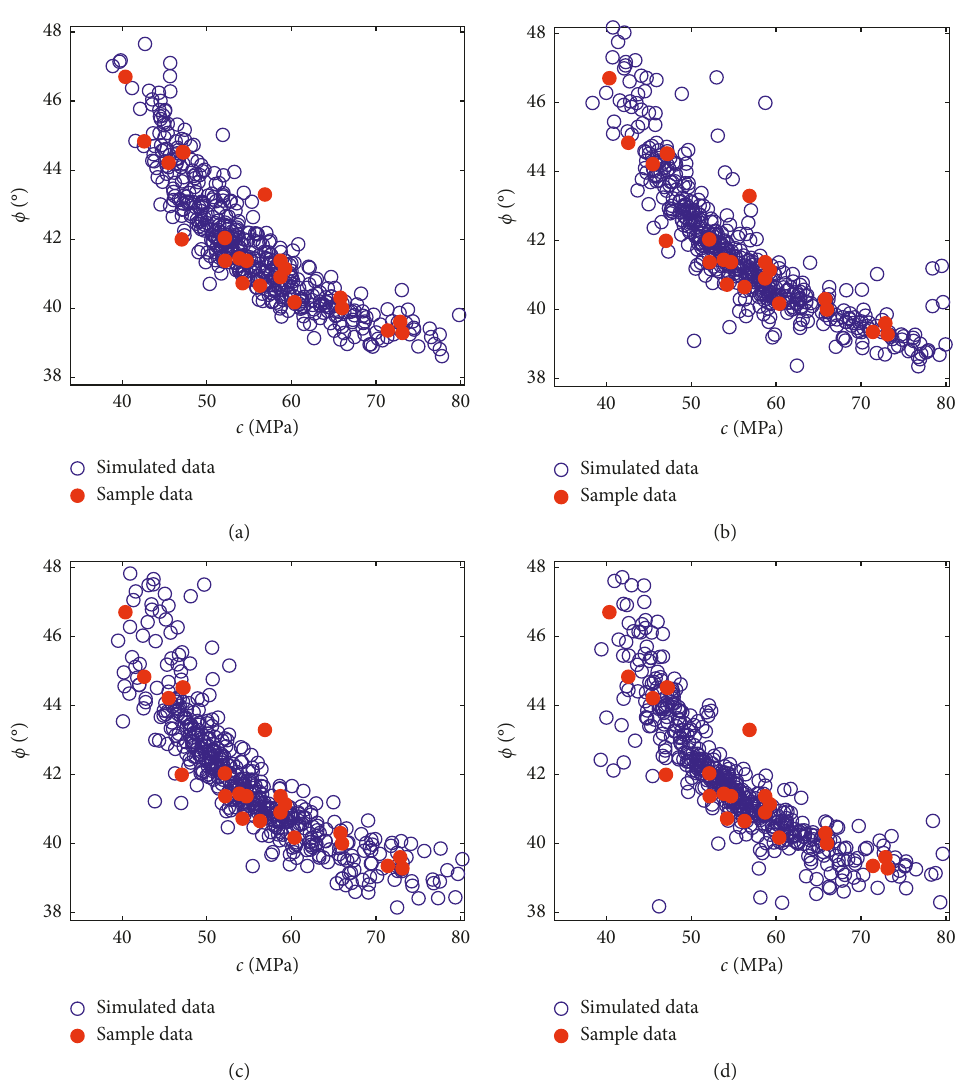
Figure 12: Scatter plots of equivalent samples generated by different copulas coupling Tunnc Gumbel margins. (a) Gaussian copula. (b) Plackett copula. (c) Frank copula. (d) No. 16